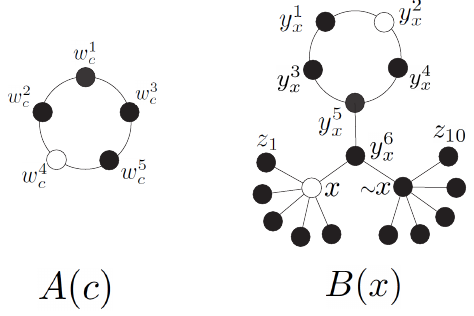
Fig. 2: The two auxiliary graphs A ( c ) and B ( x )